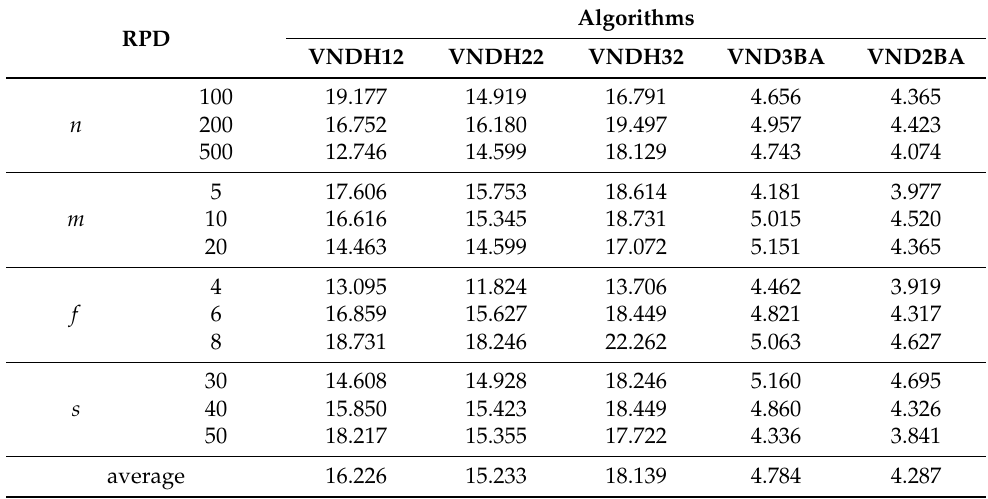
Table 13. Average RPD value of VND